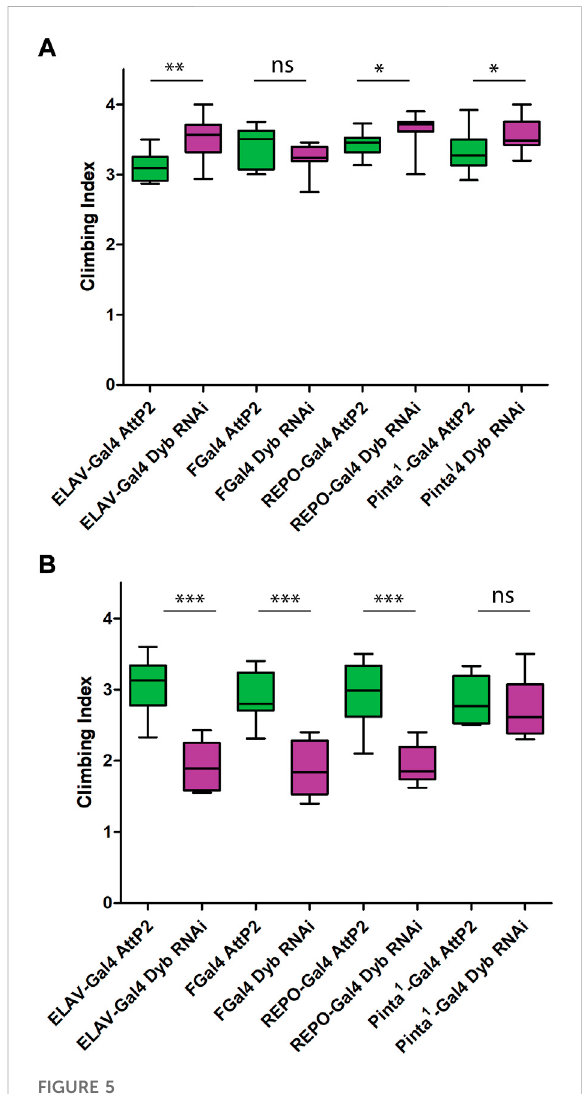
FIGURE 5 Proprioception ability is defective in cell type-speci fi c